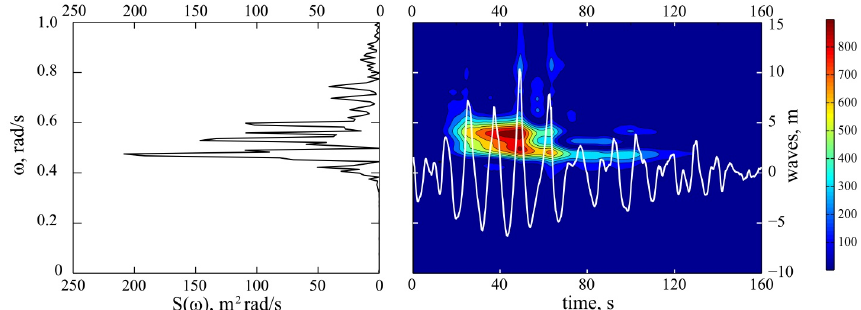
Figure 4. Time–frequency spectrum of group III between 130 and